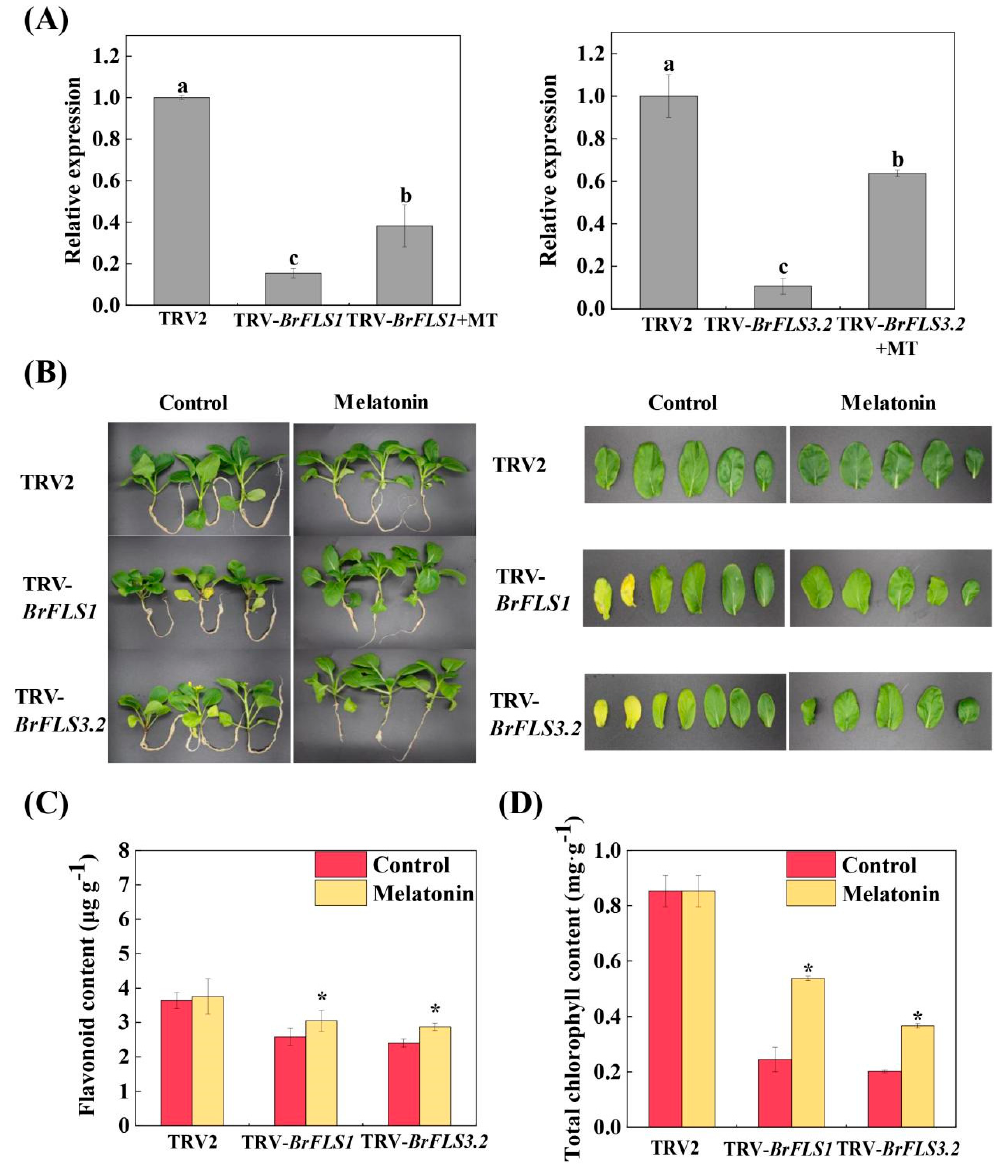
Figure 3. VIGS assay of BrFLS1 and BrFLS3.2 in flowering Chinese cabbage. ( A ), The relative transcript levels of BrFLS1 and BrFLS3.2 in TRV- BrFLS1 and TRV- BrFLS3.2 plants. ( B ), The plant and leaf phenotypes of TRV2, TRV- BrFLS1 and TRV- BrFLS3.2 plants. ( C ), Flavonoid content of TRV2, TRV- BrFLS1 and TRV- BrFLS3.2 plants. ( D ), Total chlorophyll content of TRV2, TRV- BrFLS1 and TRV- BrFLS3.2 plants. Control: 0 µ mol L − 1 melatonin (pure water). Melatonin: 100 µ mol L − 1 melatonin treatment. The vertical bars indicate the standard error of the mean (n = 3). The letters or asterisks above columns indicate a significant difference at * p < 0.05.